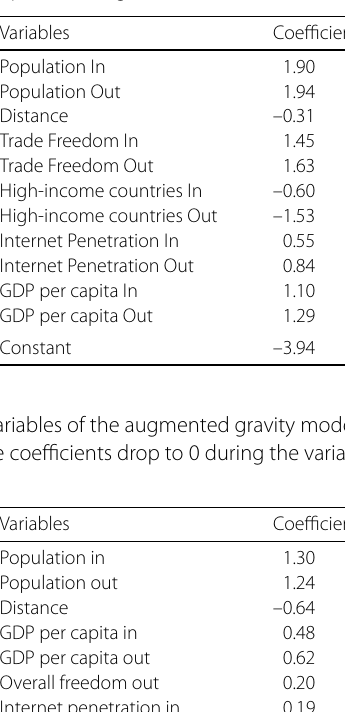
Table 7 Coefficients for the variables of the augmented gravity model with regularization, applied to the Bitcoin flow. Overall freedom index, common border and common language are excluded as their respective coefficients drop to 0 during the variable selection made through the regularization